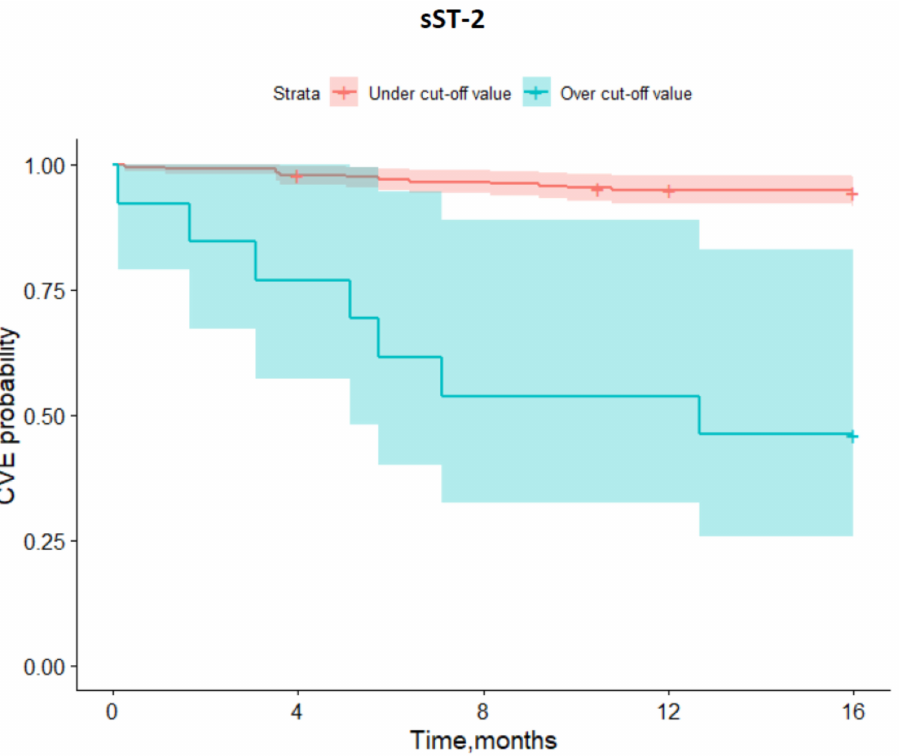
Figure 6. Kaplan–Meier survival curves for major adverse cardiovascular events (MACE) in patients, discharged after hospitalization for COVID-19 during follow-up over one year according to under- and over cut-off values for soluble suppression of tumorigenicity-2